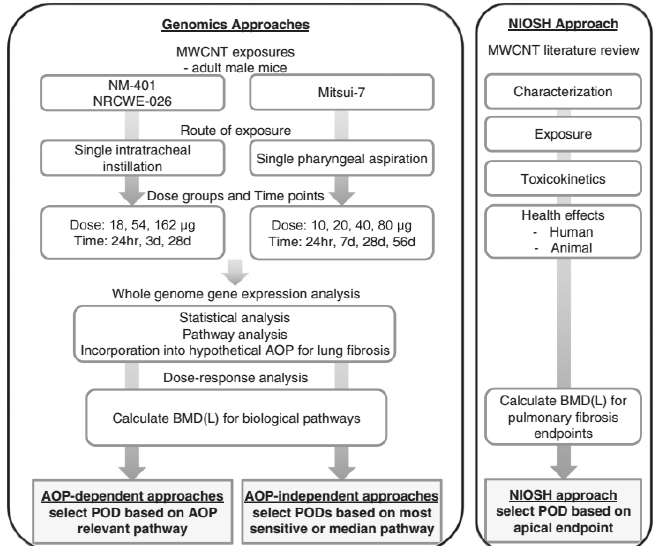
Fig. 5. Genomics approach compared with NIOSH approach for risk assessment of